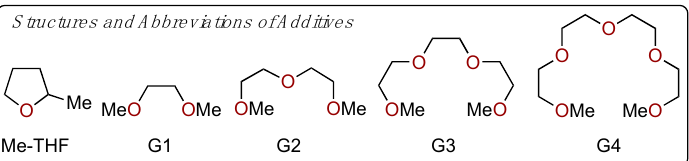
a Characterization of B-containing products were analyzed by 11 B NMR spectroscopy using a mix solvent system of 2 D Thermogravimetric analysis (TGA) (5 K/min ramp, 180 ◦ C), the large mass loss can potentially result from the decomposition of glyme, see Ref. [26]. TGA data for the Mg(BH 4 ) 2 with G1, G2, G3, and G4 (Figures S1–S4) are provided in the Supplementary Materials. Abbreviations of Additives: G1 = monoglyme; G2 = diglyme; G3 = triglyme; G4 = tetraglyme; Me-THF = 2-methyltetrahydrofuran. Unknown borane is quartet at -13 ppm in 11 B NMR assumed as 1 boron.